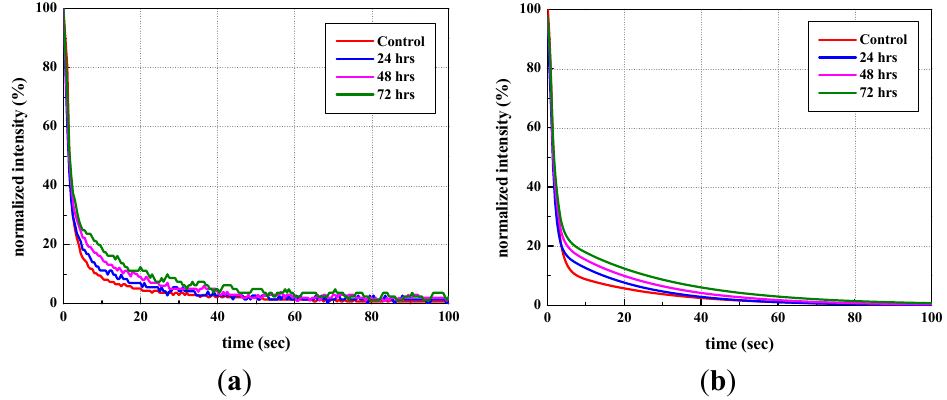
Figure 4. Normalized thermal decay curves of representative lettuce seeds that were not aged (healthy seeds) or aged for 24, 48, and 72 h. Graph ( a ) shows the measured curves, and graph ( b ) shows the curve fitted with